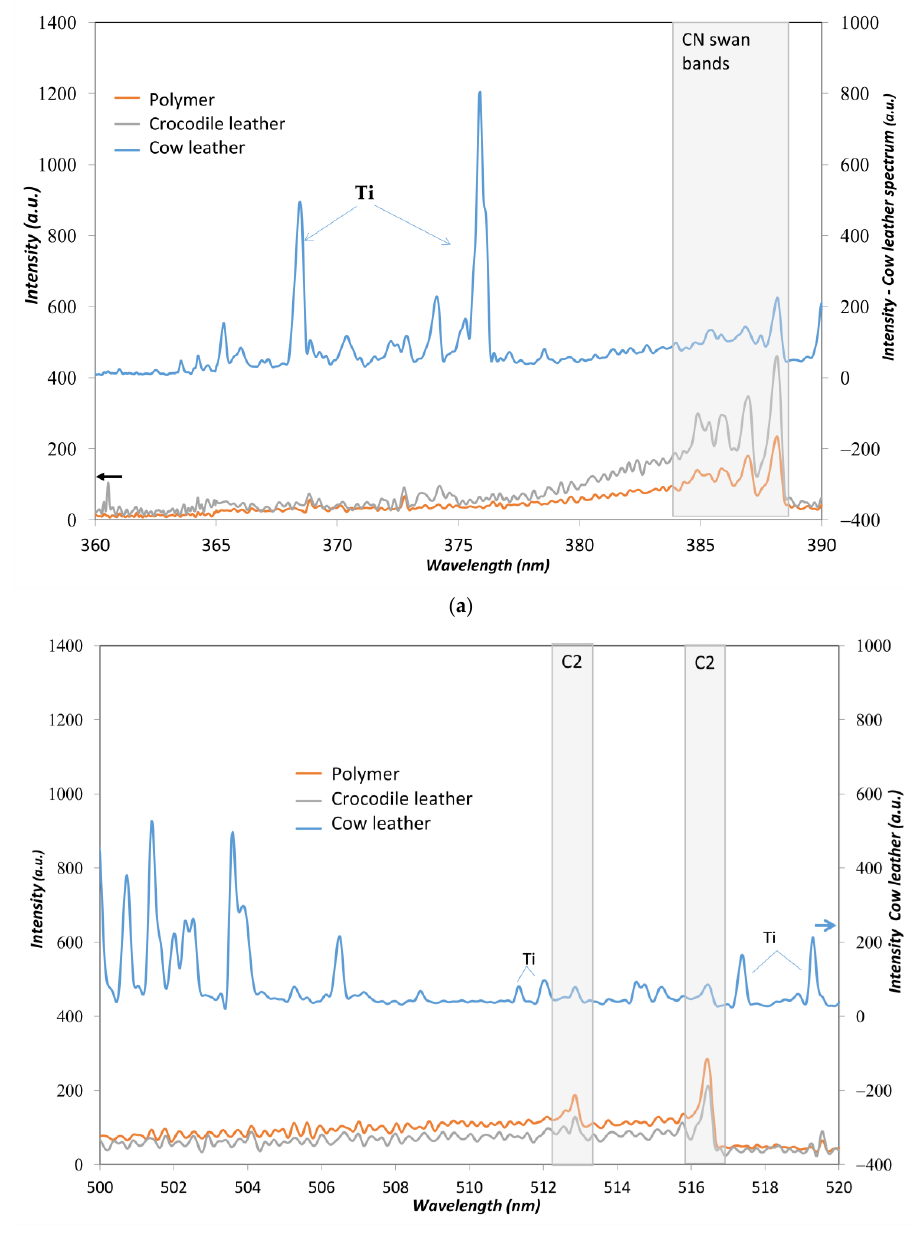
Figure 5. ( a ) CN molecular bands from cow and crocodile leather and polymer ABS. ( b ) C2 molecular bands from cow and crocodile leather and polymer ABS.